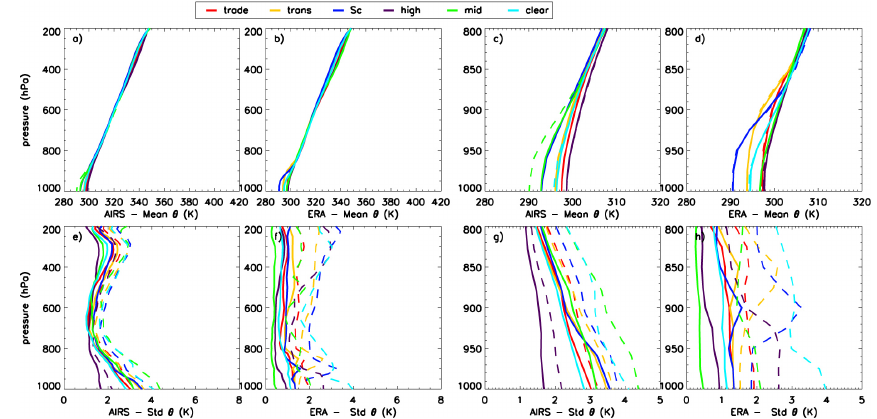
Fig. 5. The mean (panels a to d ), standard deviation (panels e and h ) of the vertical profile of θ obtained from averages of the 310-day daily snapshots (solid line) and from all profiles (dashed line). Panels (a) and (e) show AIRS/MODIS observations from 200 to 1000hPa, and panels (c) and (g) show the same AIRS/MODIS observations from 800 to 1000hPa. ERA-Interim is shown in panels (b) , (d) , (f) and (h) .